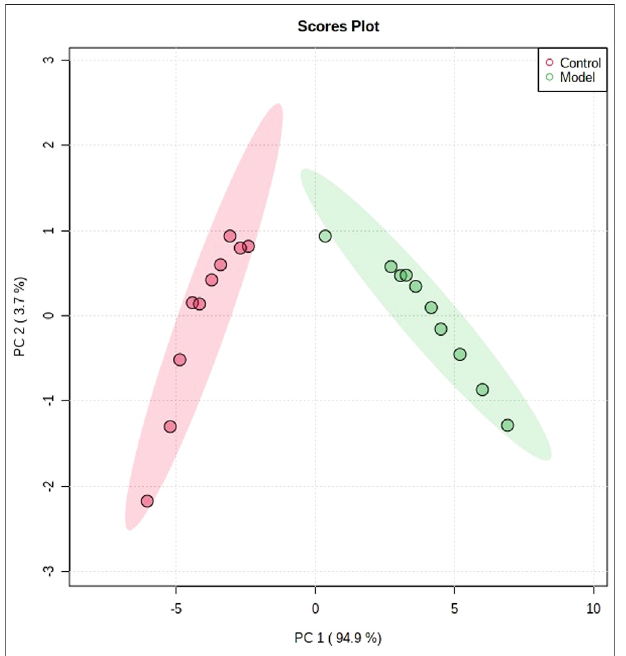
FIGURE 2 | Hierarchical clustering dendrogram for the control and model